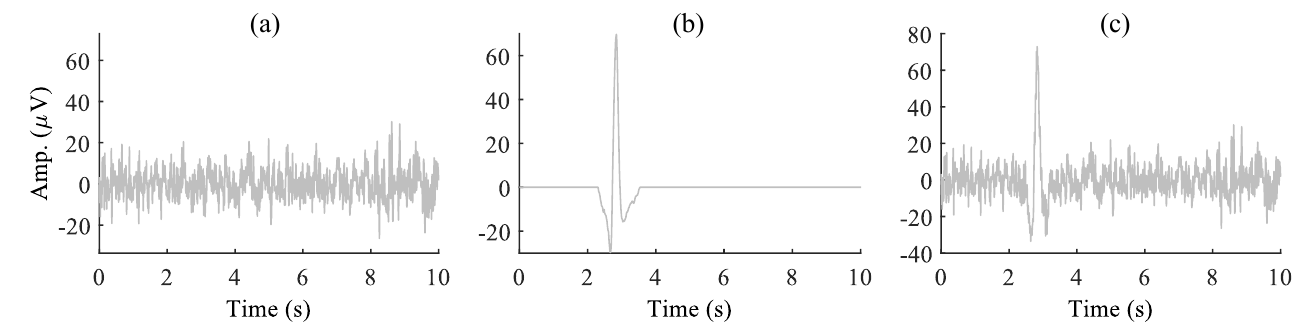
Figure 2. ( a , b ) Synthetically constructed ground truth EEG signal ( s ) and the EOG artifact ( a ), respec- tively, and ( c ) the contaminated EEG signal x = s + p a for the artifact mixing constant p =